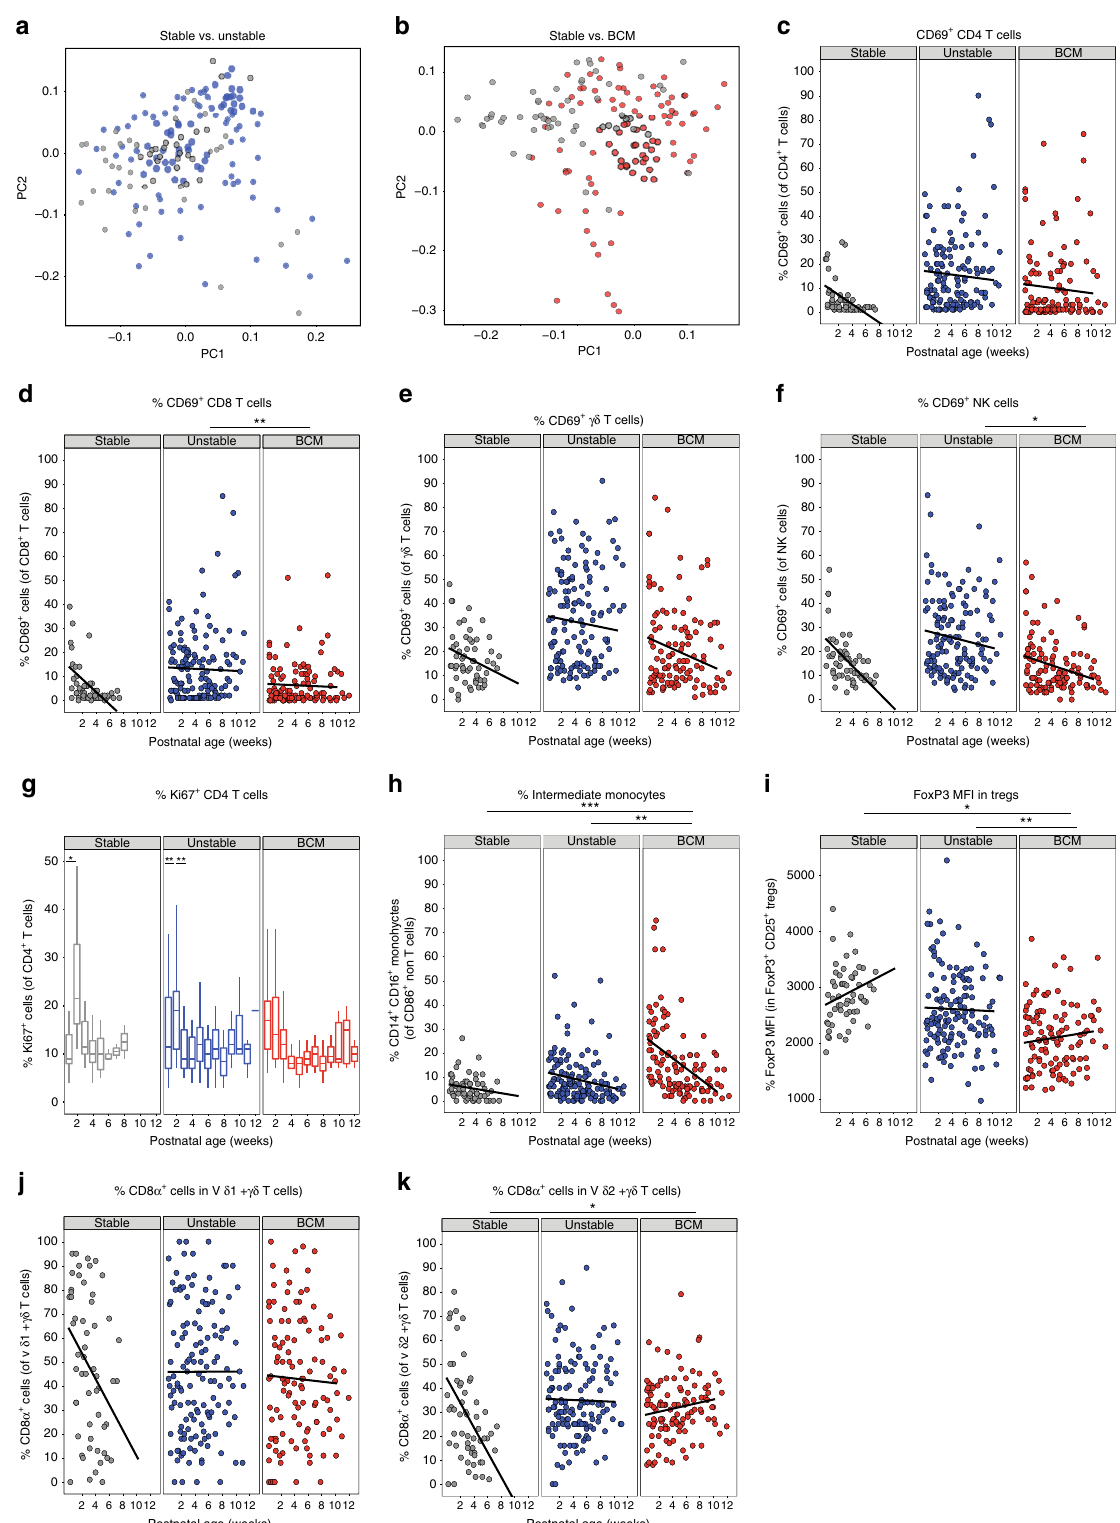
The principal effector chemokine of neonatal CD4 T cells is CXCL8 10 . CXCL8 expression was highly divergent between infants and adults, and there was a strong correlation between CXCL8-producing CD4 and CD8 T cells in our babies, regardless of GA at birth. Levels of CXCL8-producing αβ T cells did not signi fi cantly decrease towards adult levels over the time